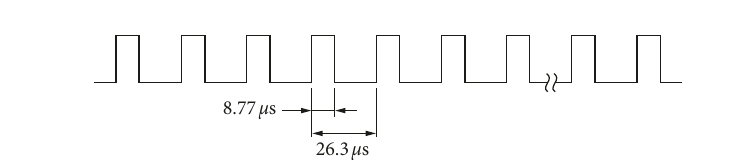
Figure 2: Pulse cycle of signal carrier of NEC protocol.